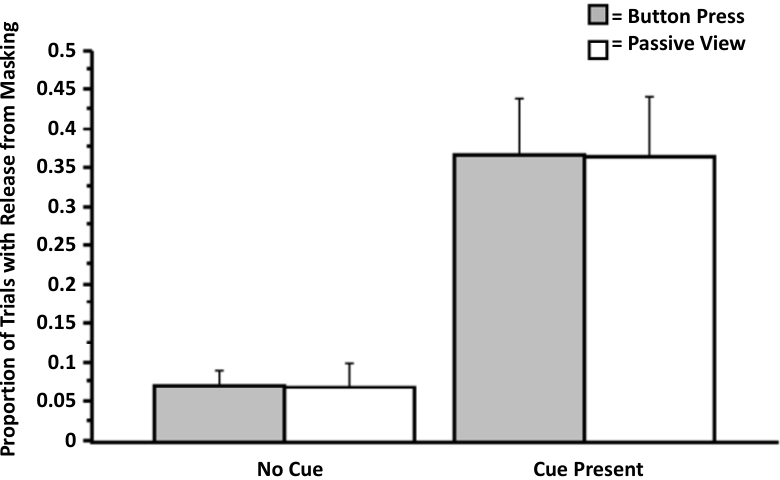
Figure 4. Proportion of trials involving release from masking as a function of bottom-up perceptual cueing and action (a simple button press) (Experiment 1). The data presented here stem from the question, “Did you see anything on the screen other than the pattern mask?” Error bars signify SEMs .